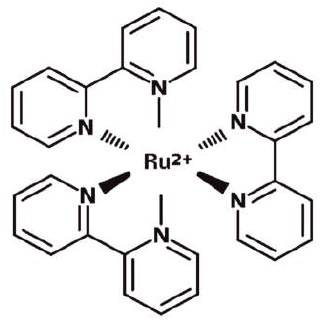
Figure 1. Structure of Ru(bpy) 32+ .